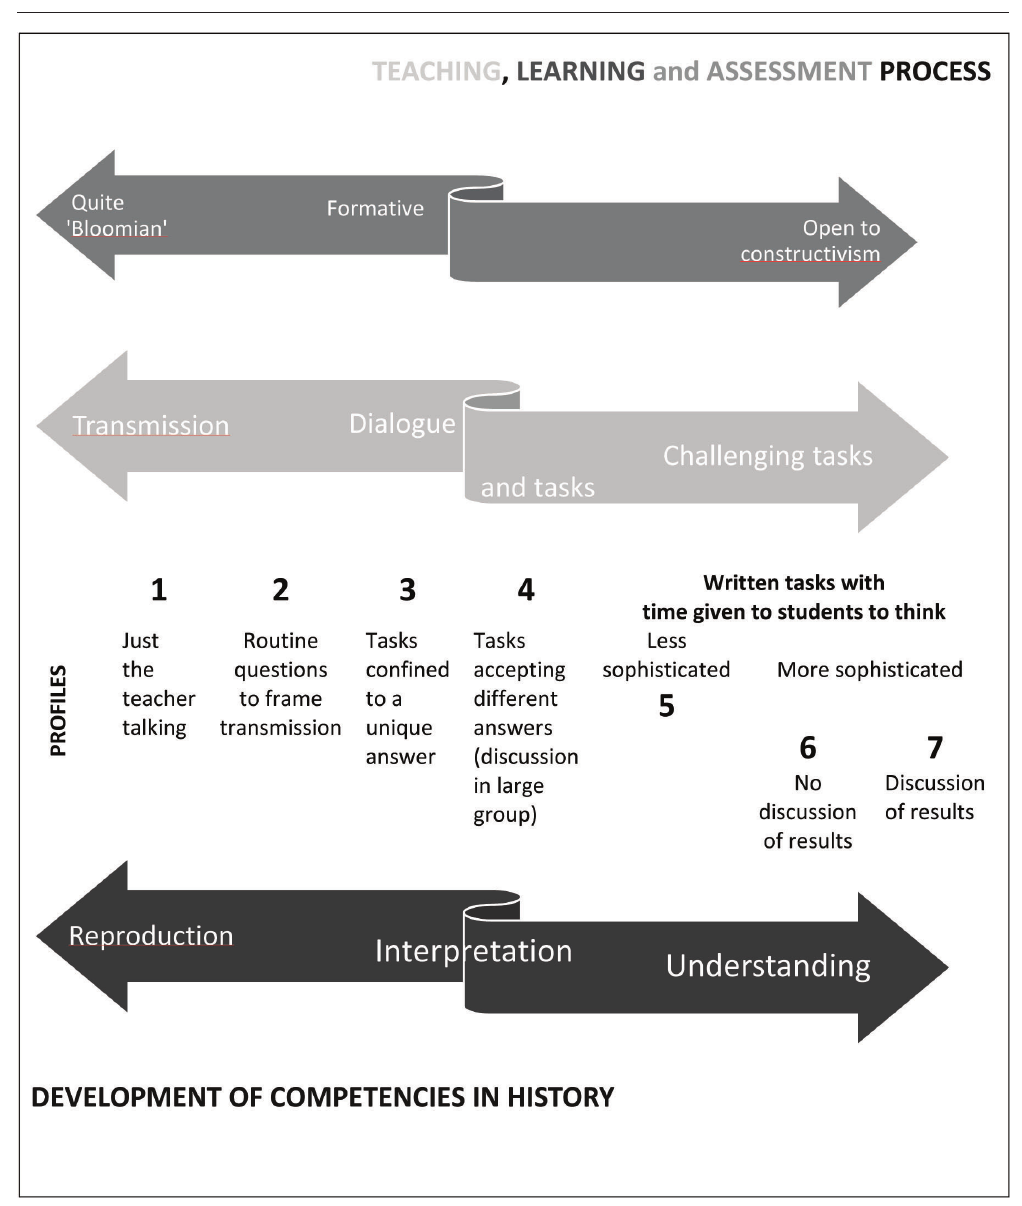
Figure 1: Different profile moments that may occur during a